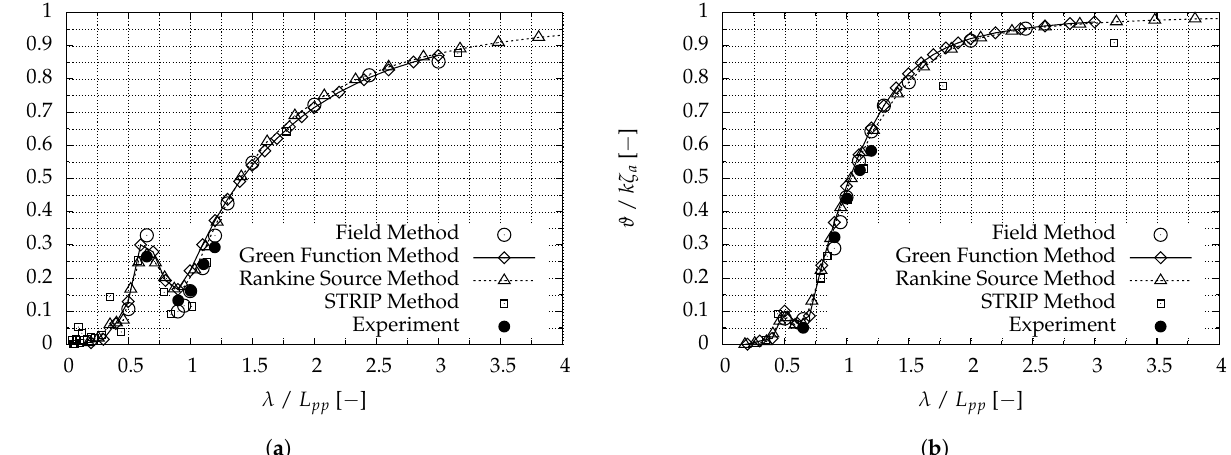
Figure 3. Cruise ship: computed and measured RAOs. ( a ) Heave motion ζ and ( b ) pitch motions ϑ . ζ a is the wave amplitude, k the wave number, λ the wave length and L pp the ship length.